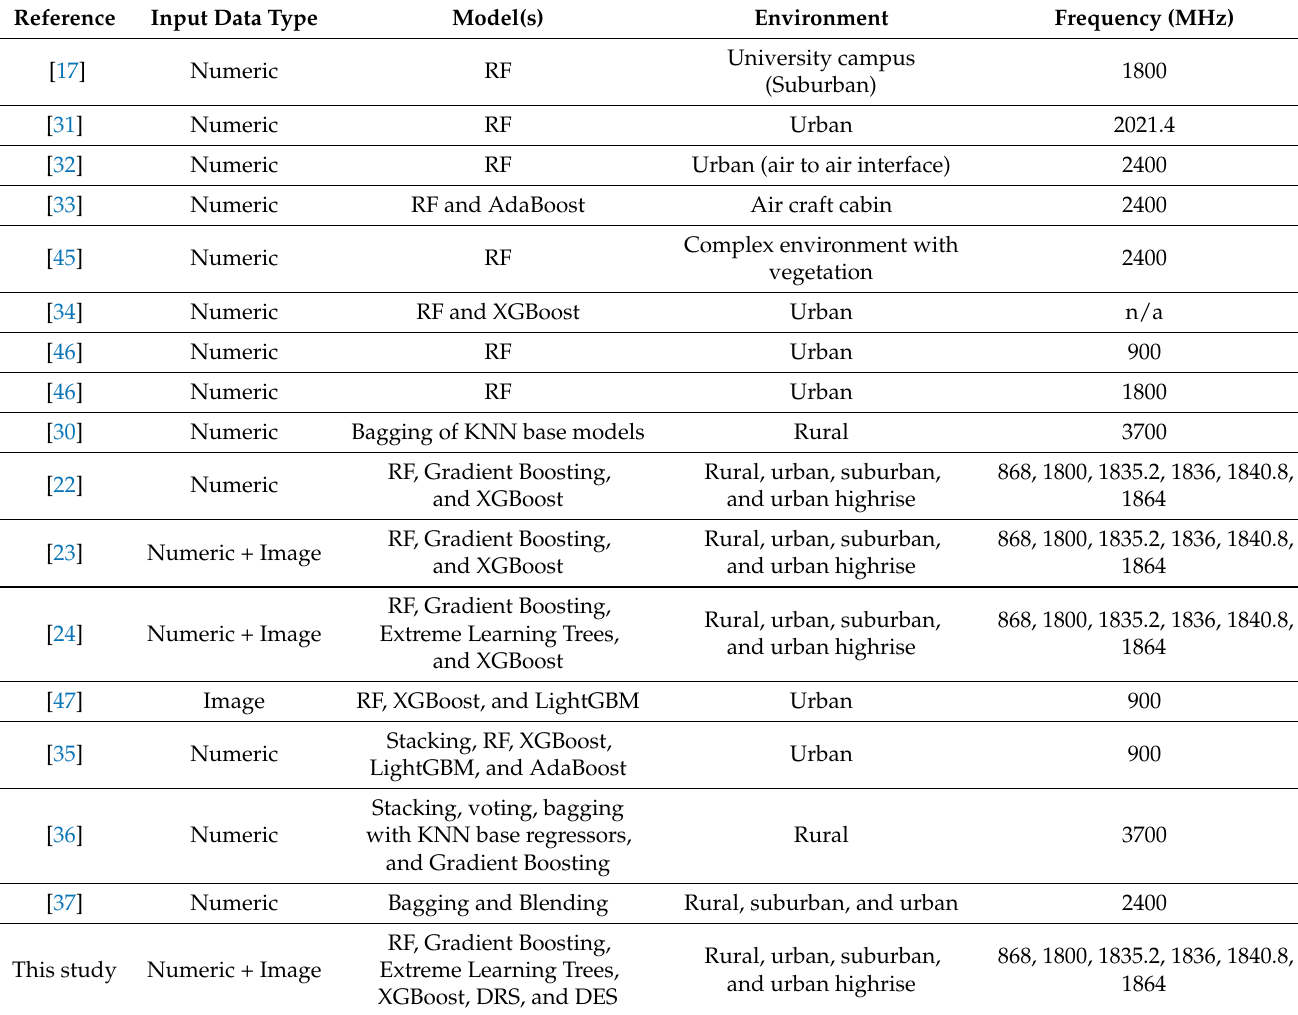
Table 1. Summary of previous works that used ensemble models for path loss